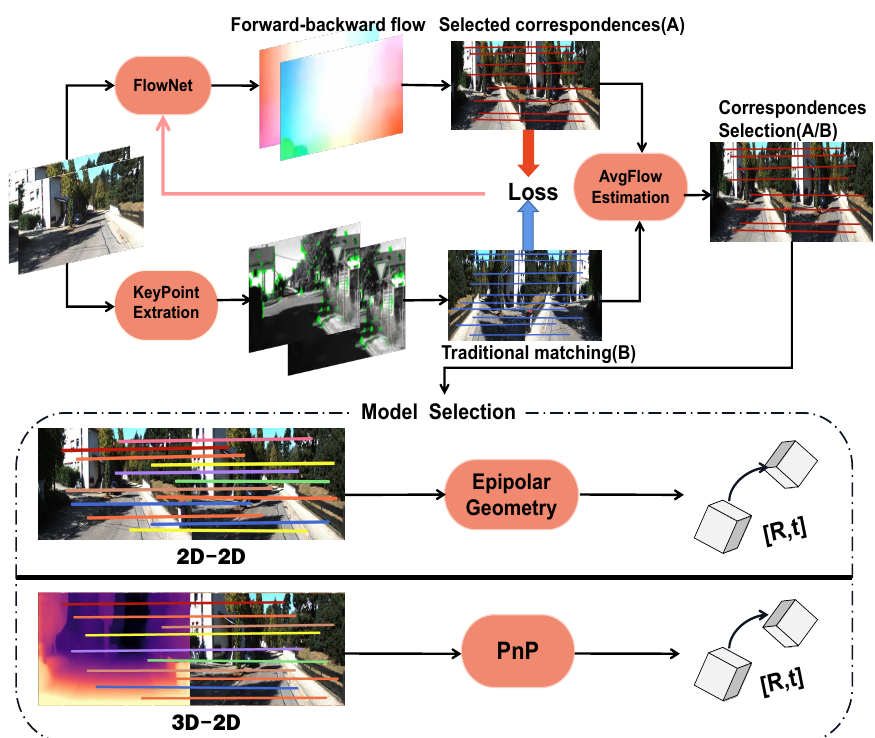
Figure 2. System overview. The FlowNet predicts optical flows between adjacent frames. Afterward, we use the forward–backward flow consistency score map to select the corresponding point pairs set, denoted as A. Meanwhile, another matching point pairs set B is created by the traditional key point extraction and matching algorithm. The AvgFlow estimation module judges how fast the scene motion is. Moreover, in the loss function of the optical flow network, the Euclidean distance between A and B is added as the supervisory